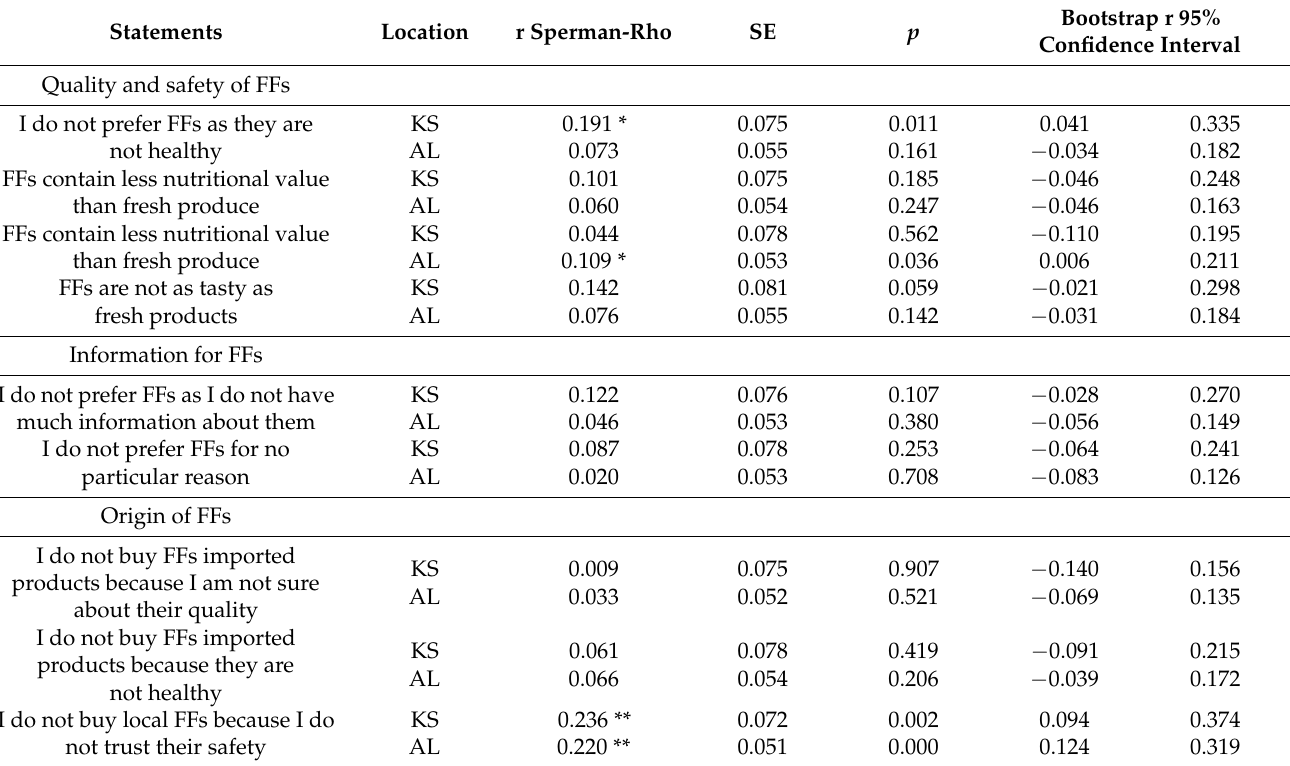
Table 5. Correlation coefficients between education and consumers’ perception for frozen foods in Kosovo and